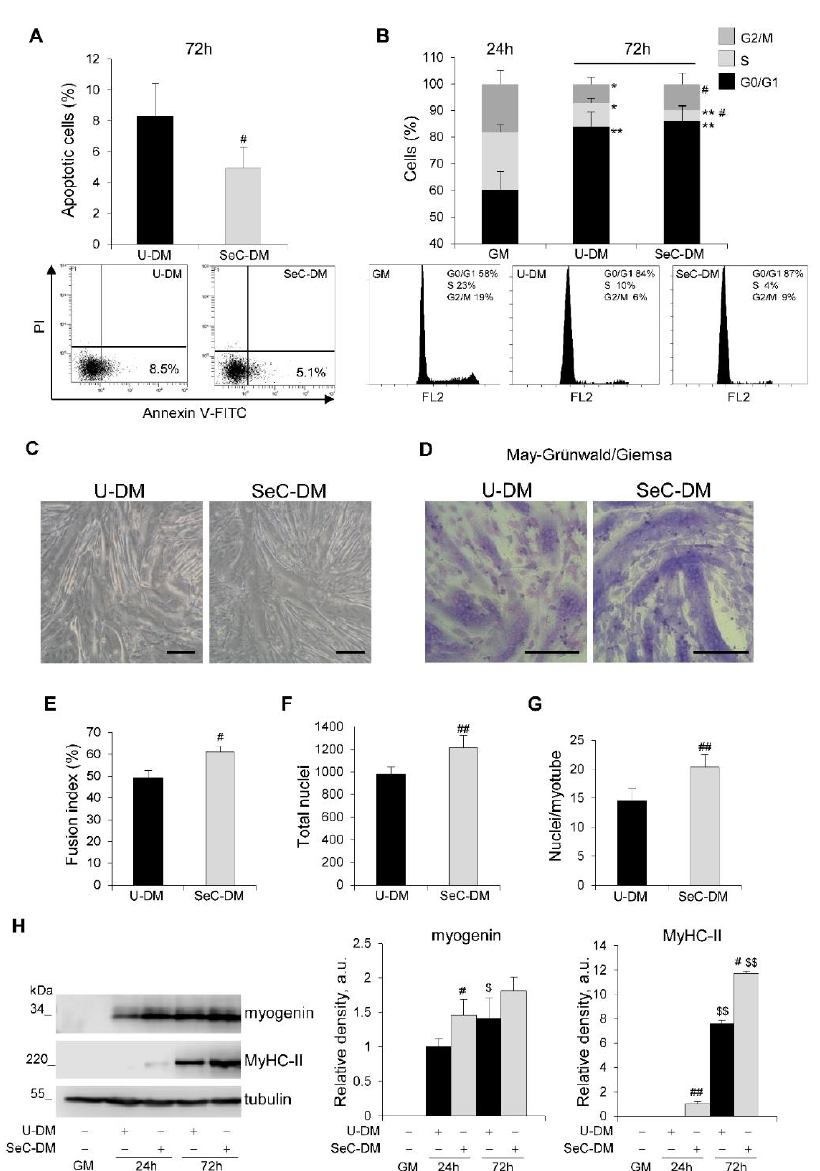
Figure 2. SeC promote myogenic terminal differentiation. ( A – G ) C2C12 myoblasts were cultivated either in growth medium (GM) for 24 h or in unconditioned medium (U-DM) or DM conditioned by Sertoli cells (SeC-DM) for 72 h. FACS analysis